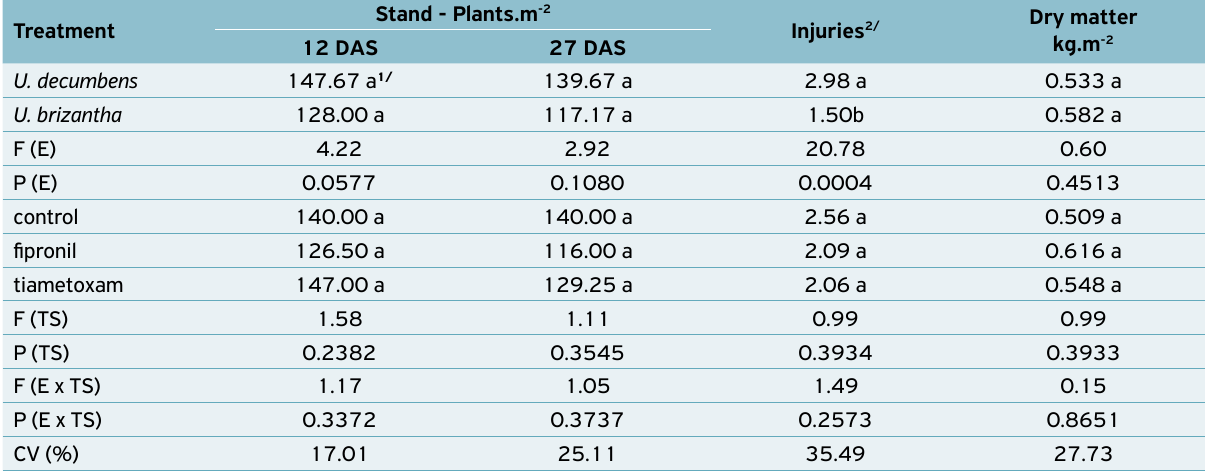
Table 2. Number of plant stands; injuries caused by D . flavopicta adults; dry matter yield of U . decumbens and U . brizantha , submitted to seed treatments with insecticides. São José do Rio Preto SP Brazil, 2015/16.